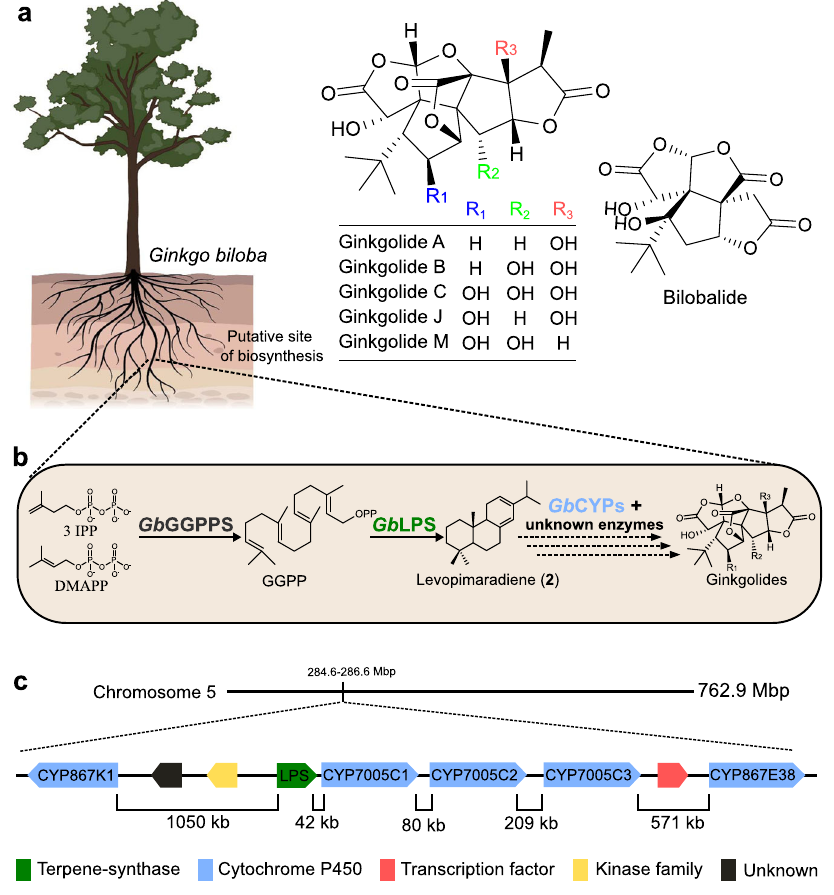
Fig. 1 | Biosynthesis of ginkgolides. a Chemical structure of ginkgolides (diter- penoids) and bilobalide (sesquiterpenoid). The tree image has been created by BioRender.com (2021). b Ginkgolide biosynthesis is suggested to take place in the roots of the tree, as indicated by the dashed lines. Geranylgeranyl pyrophosphate synthase ( Gb GGPPS) is producing geranylgeranyl pyrophosphate (GGPP), which initiates the biosynthesis of all diterpenoids. Next, levopimaradiene synthase ( Gb LPS) converts GGPP to diterpene hydrocarbon levopimaradiene, which is the hypothesizedprecursorofginkgolides.Ithasbeenproposedthatlevopimaradiene